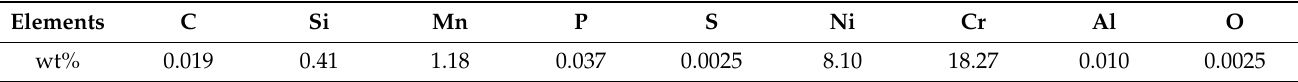
Table 1. Chemical compositions of the electrode material.